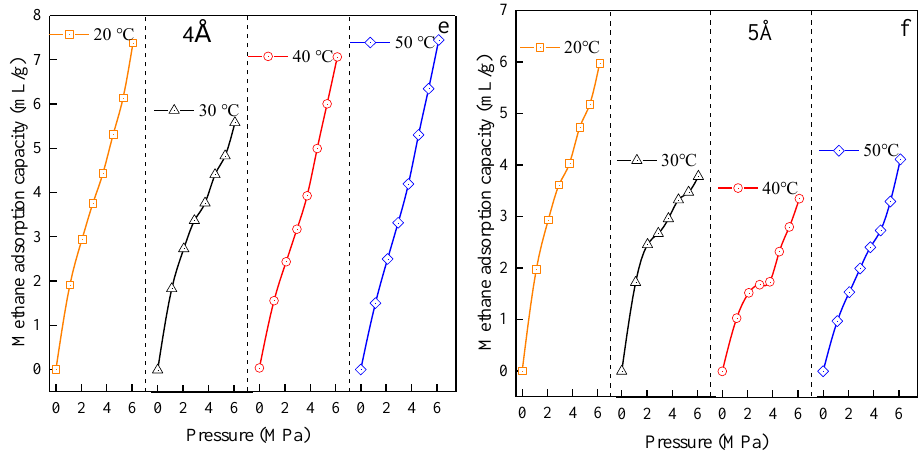
Figure 5. Adsorption isotherms of testing materials in different temperature: ( a ) Aiweiergou 1890# working face coal sample; ( b ) Activated alumina; ( c ) Silica gel; ( d ) 3Å molecular sieve; ( e ) 4Å molecular sieve; ( f ) 5Å molecular sieve.